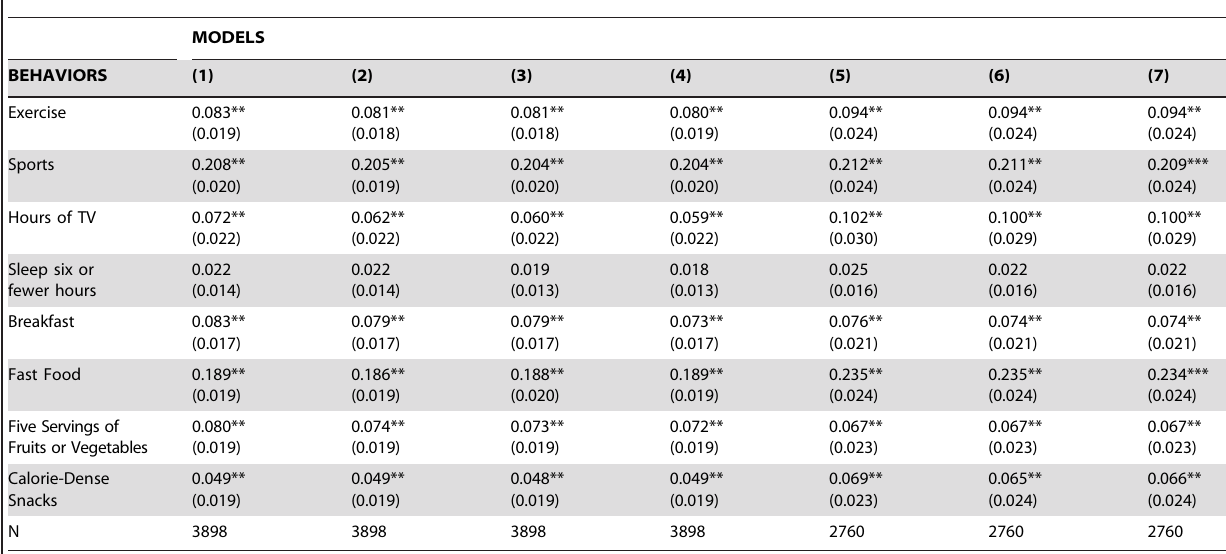
Table 3. Estimated Friendship Network Effects (without school–level Fixed